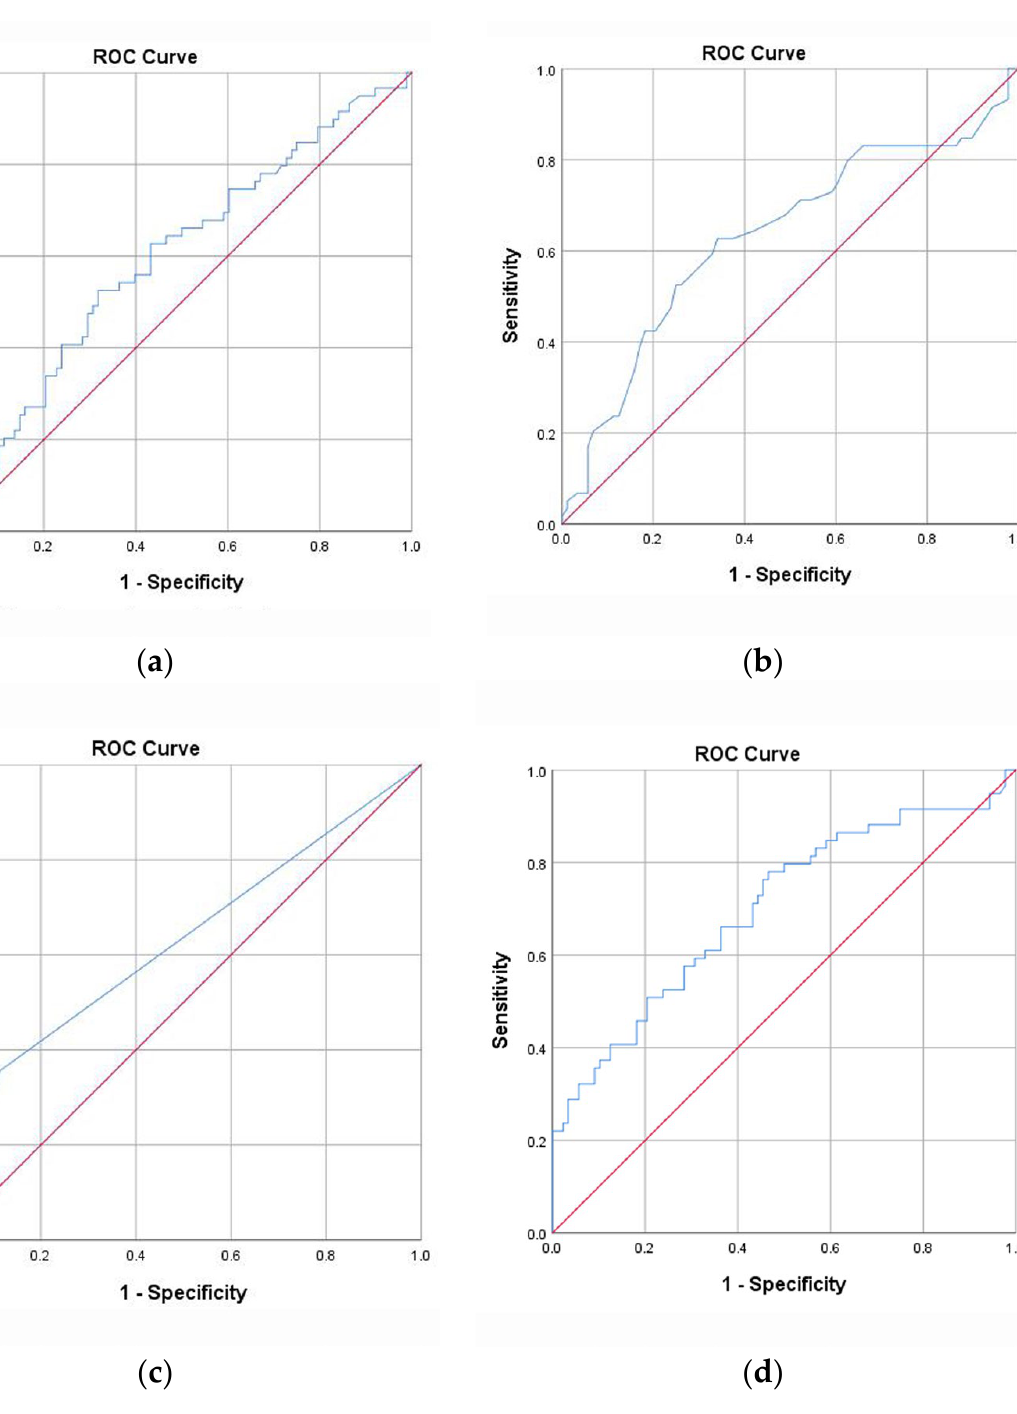
Figure 2. Risk factors and the combined method for predicting LNM in the external validation group. ( a ) Tg. ( b ) Age. ( c ) US alone. ( d ) Combined diagnosis. LNM, lymph node metastasis; ROC, receiver operating characteristic; Tg, serum thyroglobulin; US, ultrasound.